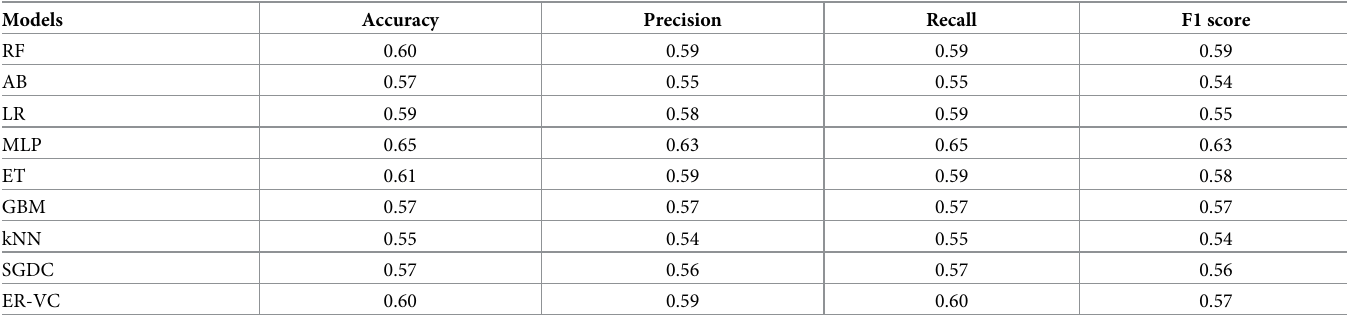
Table 5. Classification results of machine learning models using GloVe on imbalanced dataset. Models